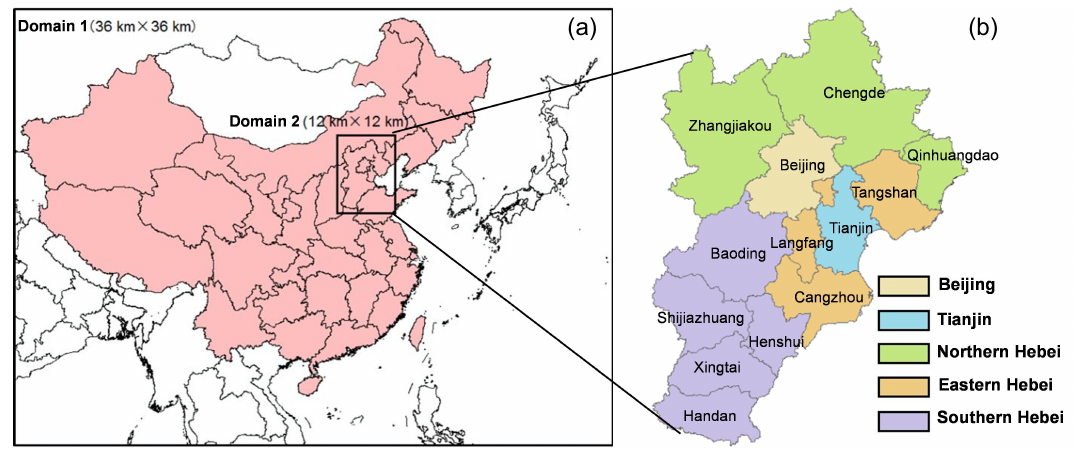
Figure 1. Double nesting domains used in CMAQ/2D-VBS simulation (left) and the definition 2 Figure 1. Double-nesting domains used in CMAQ/2D-VBS simulation (a) and the definition of five target regions in the innermost domain, denoted by different colors (b) . The grey lines in (b) represent the boundaries of prefecture-level cities. of five target regions in the innermost domain, denoted by different colours (right). The grey 3 lines in the right figure represent the boundaries of prefecture-level cities. 4 We compared the simulation results of WRFv3.7